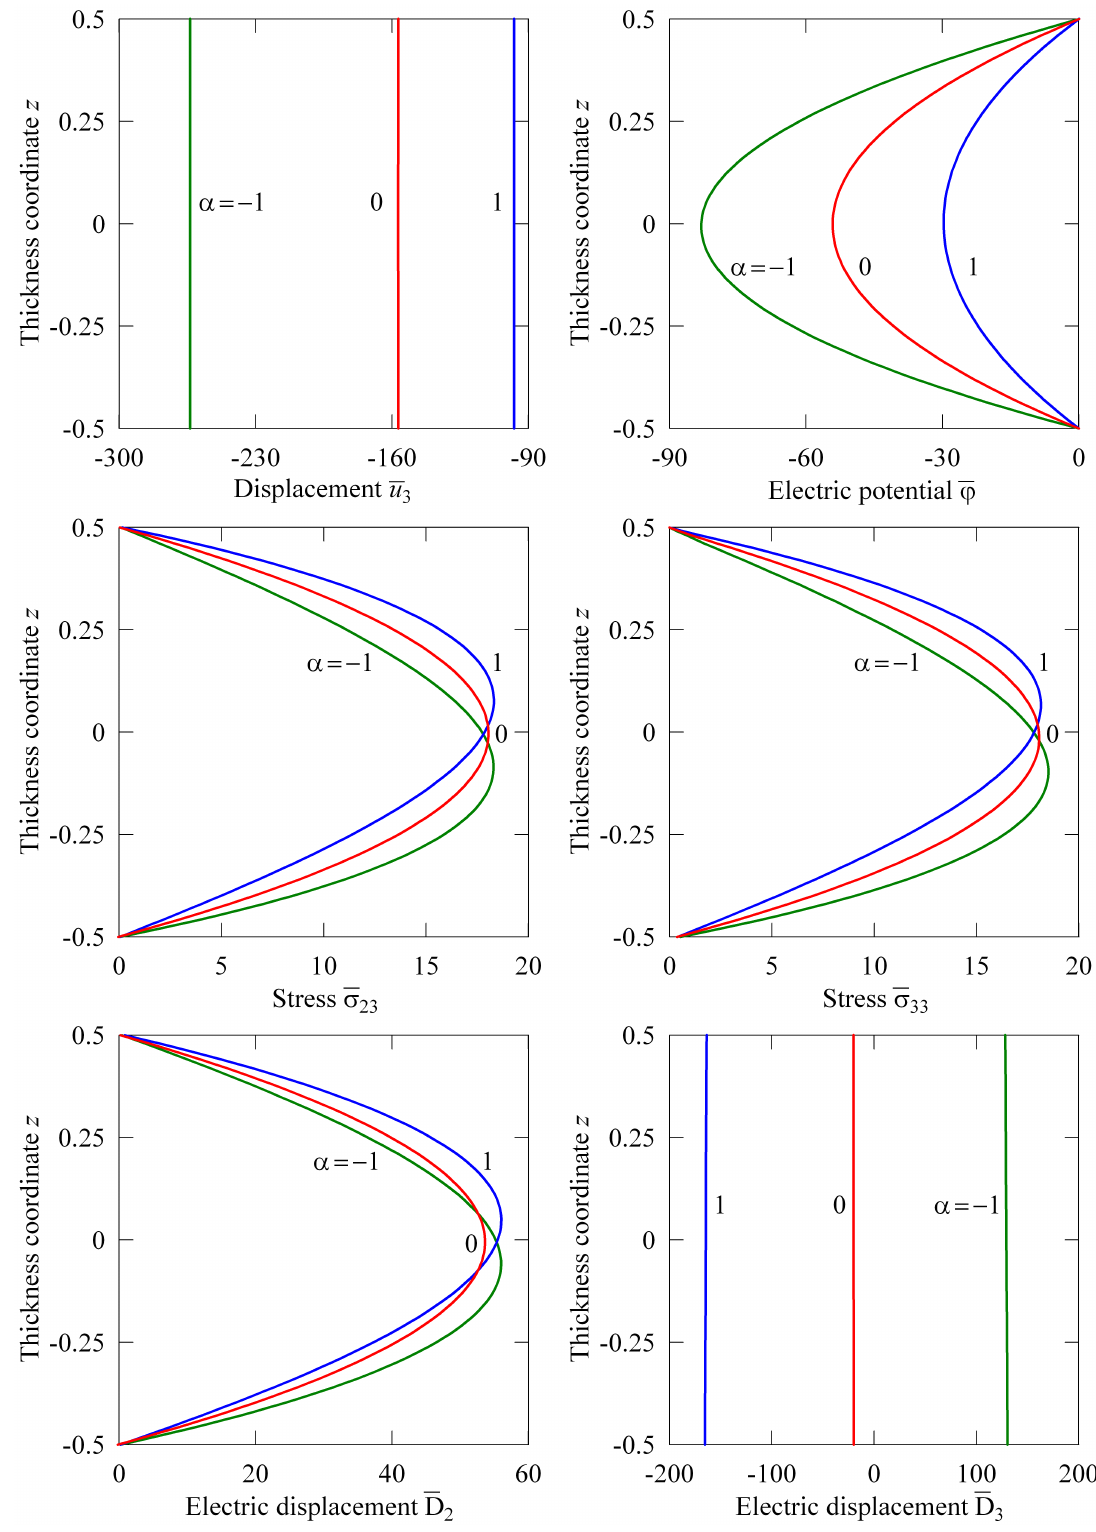
Figure 15: Through-thickness distributions of the transverse displacement, stresses, electric potential and electric displacement for a thin cylindrical shell using five